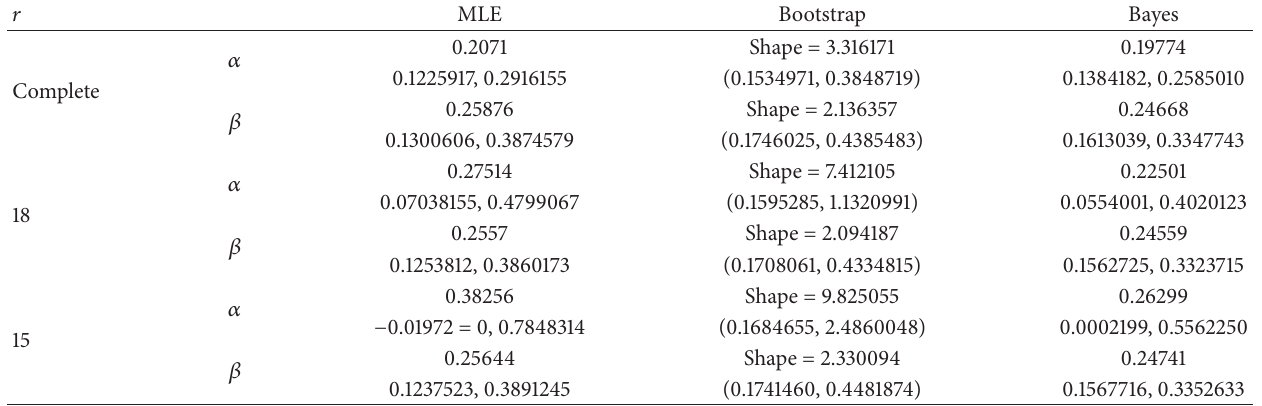
Table 9: Estimates and confidence/HPD/bootstrap intervals for real data set.